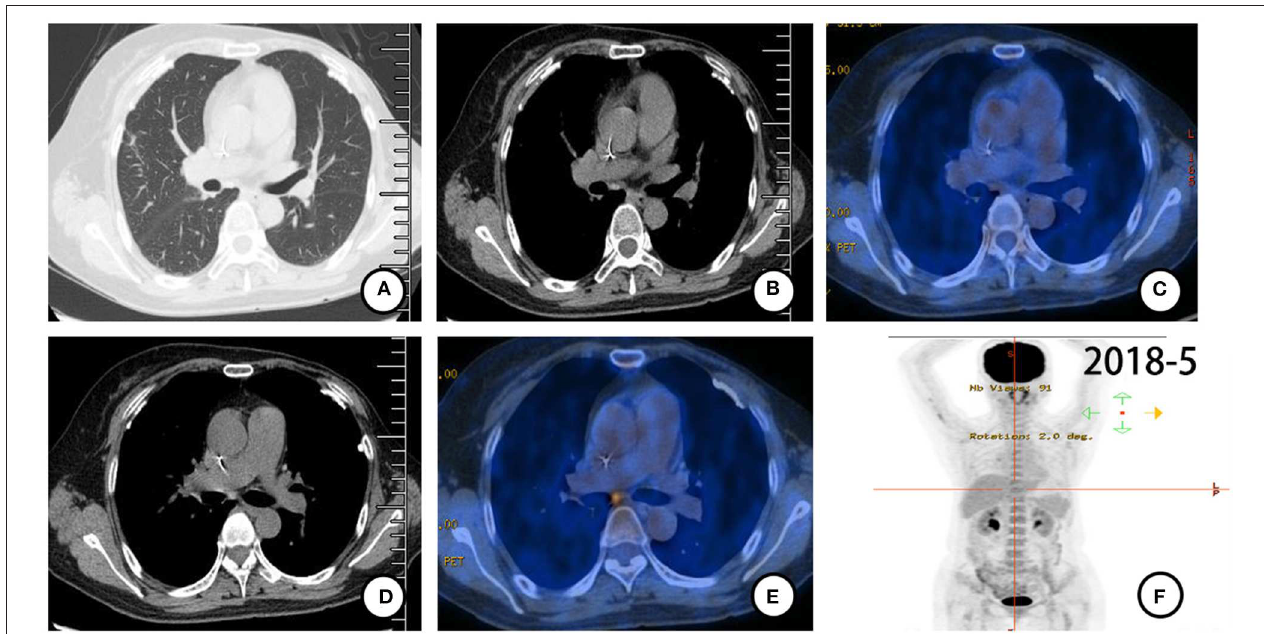
FIGURE 3 | PET-CT (May 2018) scan after 6 cycles of combination treatment with trastuzumab, vinorelbine, and capecitabine. (A–F) All metastases shrank with almost no FDG uptake.